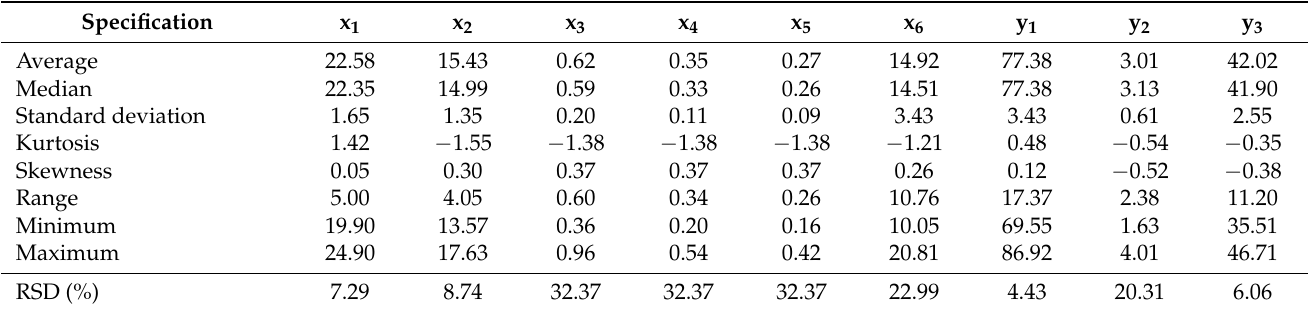
Table 13. Descriptive statistics of chemical composition of tubers and color in the CIELab system of raw tuber flesh.